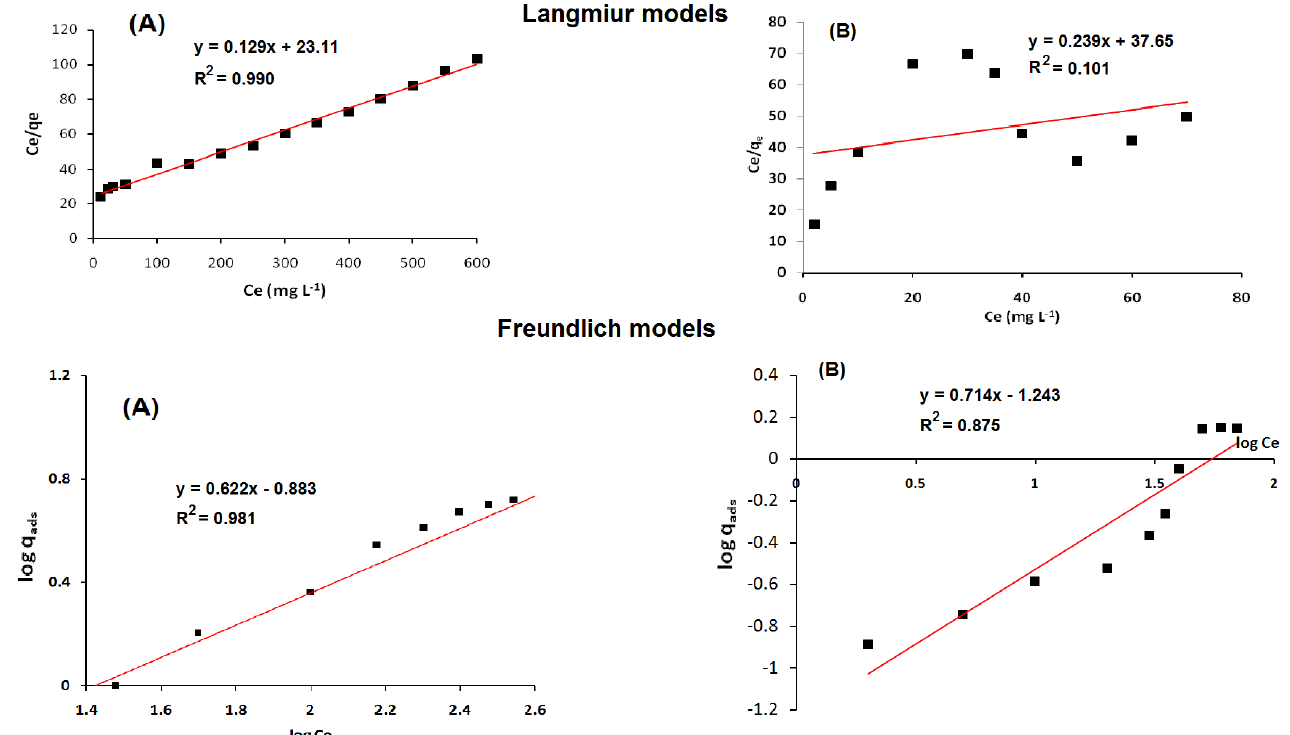
FIGURE 13 - Langmiur and Freundlich models for adsorption of CAF by: (A) AY-GPUF and (B) AY-IPUF